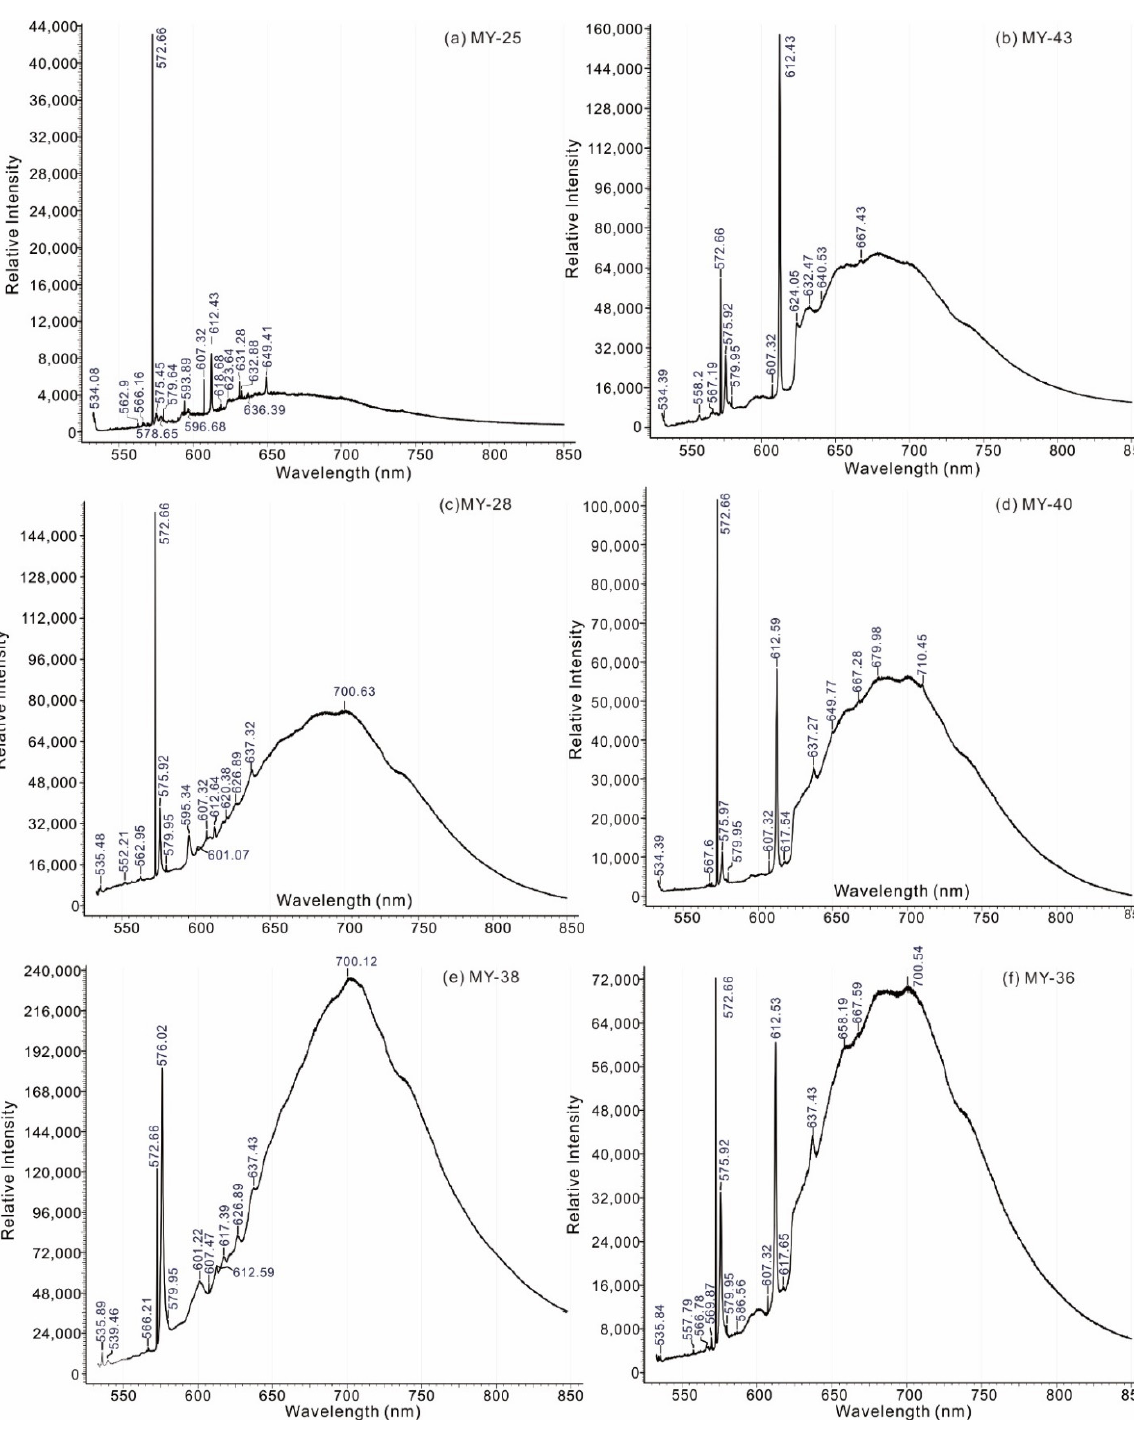
Figure 5. Low Temperature Photoluminescence diagrams of representative brown diamonds from the Mengyin deposit under liquid nitrogen